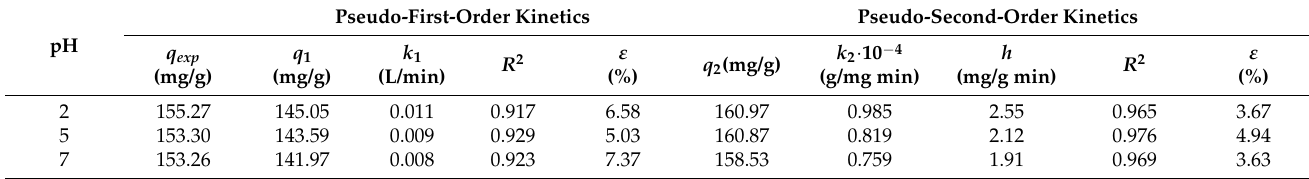
Table 1. The parameters of kinetic models for RY2 adsorption on PEI/PVC-CF at pH 2.0, 5.0, and 7.0. Pseudo-First-Order Kinetics Pseudo-Second-Order pH